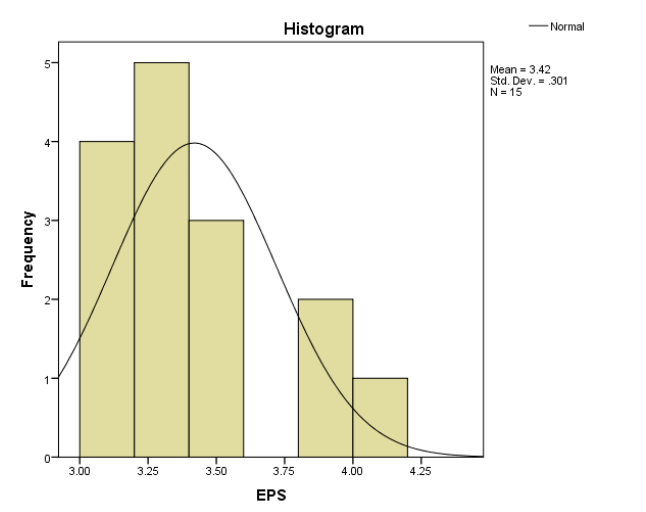
Figure 1. Normality test histogram for EPS